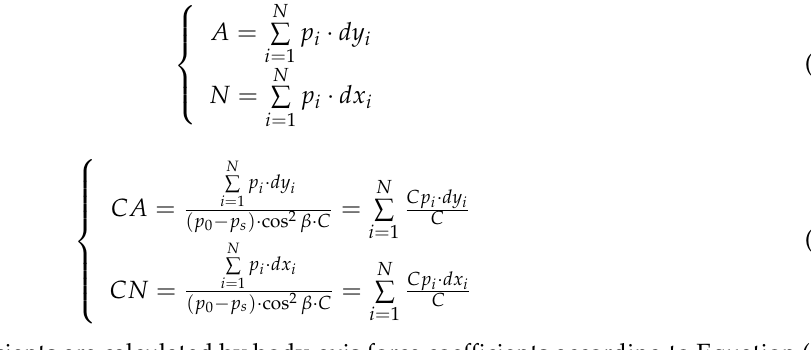
Figure 9. Effective angle of attack measured by leading-edge probe.